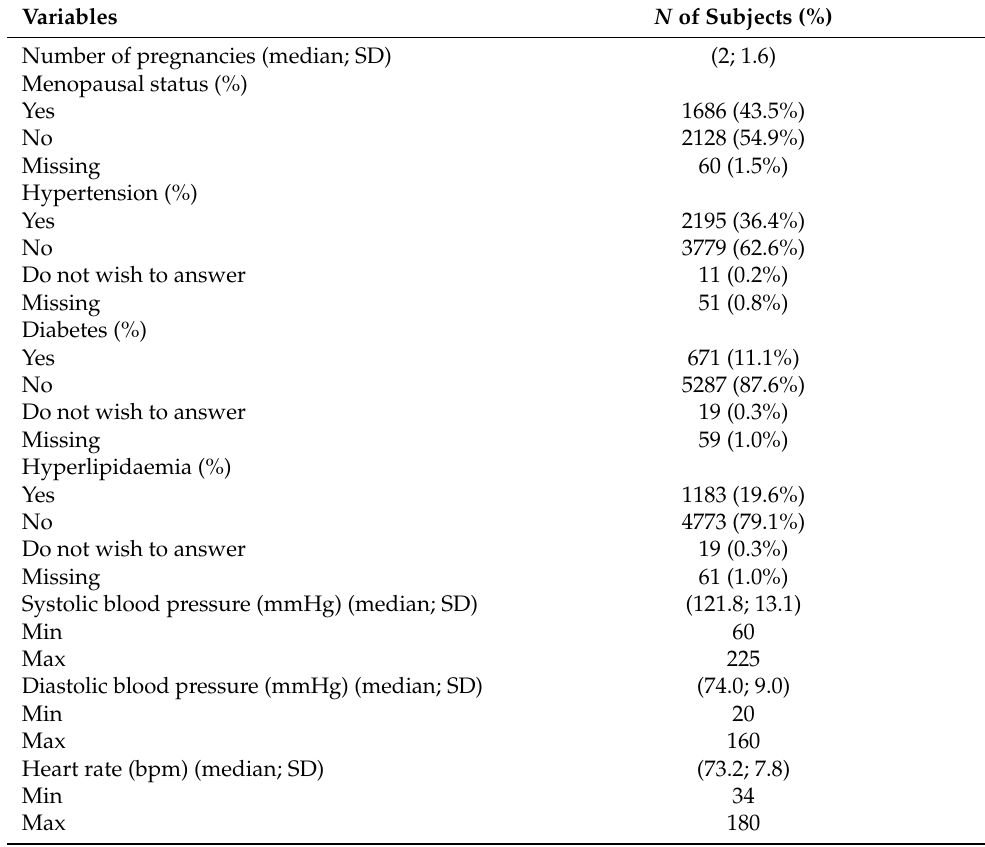
Table 3. Characteristics of the analysed cohort: physiological and pathological